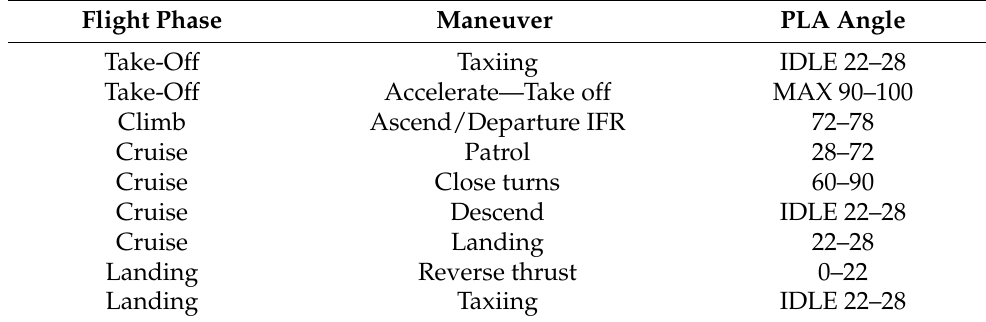
Table 4. EMB-145 Typical PLA settings.